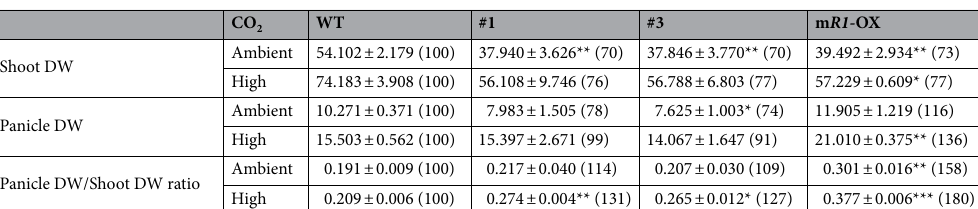
Table 2. Characterization of shoots and panicles of mature WT, R1 -Cas #1 and #3, and m RDD1 -OX plants (m R1 -OX) at the mature stage under ambient and high CO 2 conditions. Data are represented as the average ± standard error of the mean ( n = 3–4). Asterisks indicate significant differences relative to the WT plants based on the Student’s t -test (* P < 0.05, ** P < 0.01 and *** P < 0.001). Values relative to those of WT as 100 are shown in parentheses. DW, dry weight.